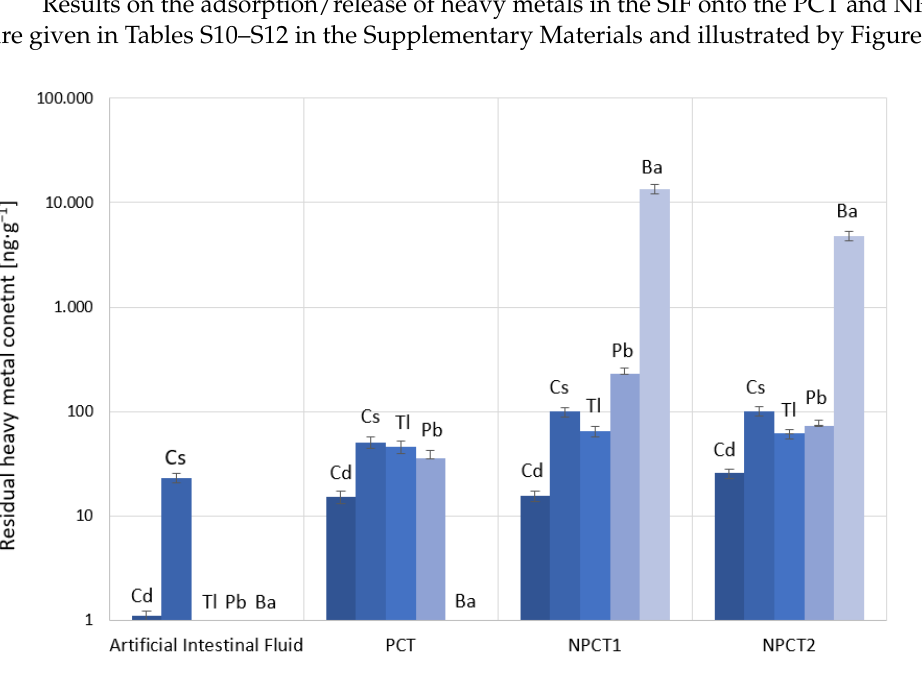
Figure 4. Adsorption/release of heavy metal ions in SIF from the PCT, NPCT1, and NPCT2 (log-scale). The figure is based on data from Tables S10–S12 in the Supplementary Materials.